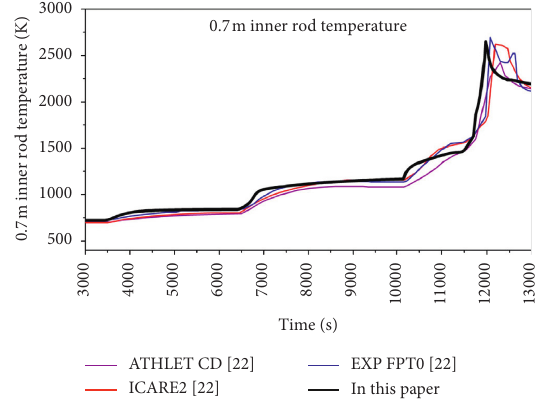
Figure 13: Variation of inner ring fuel rod temperature at